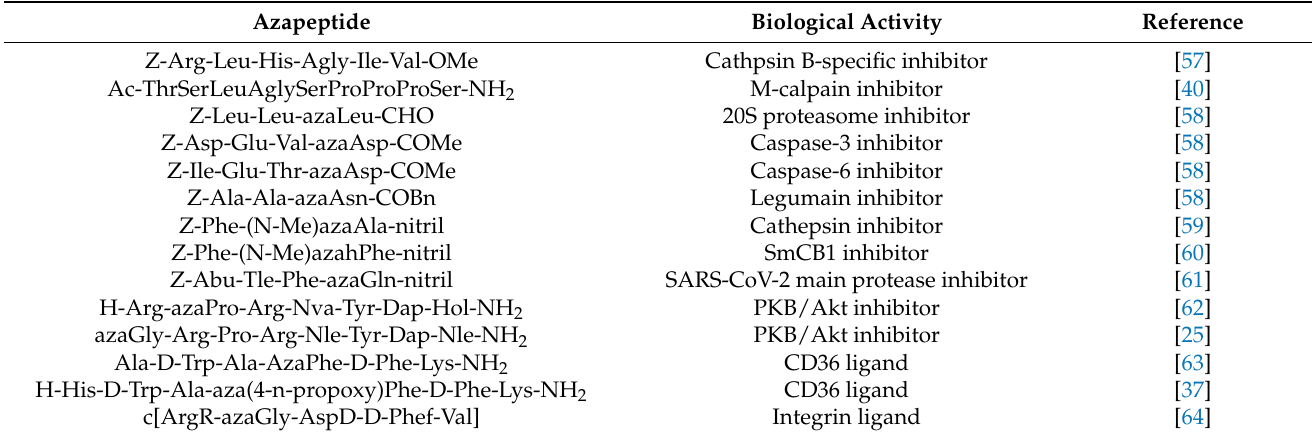
Table 1. Azapeptides with different biological